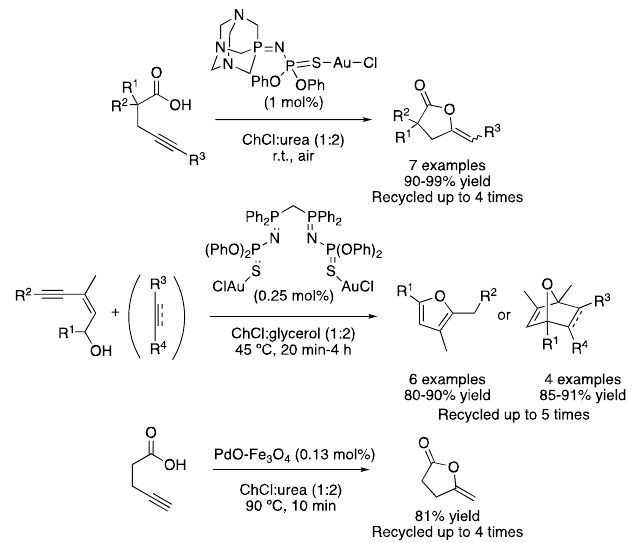
Figure 9. Cycloisomerization reactions catalyzed by Au and Pd.